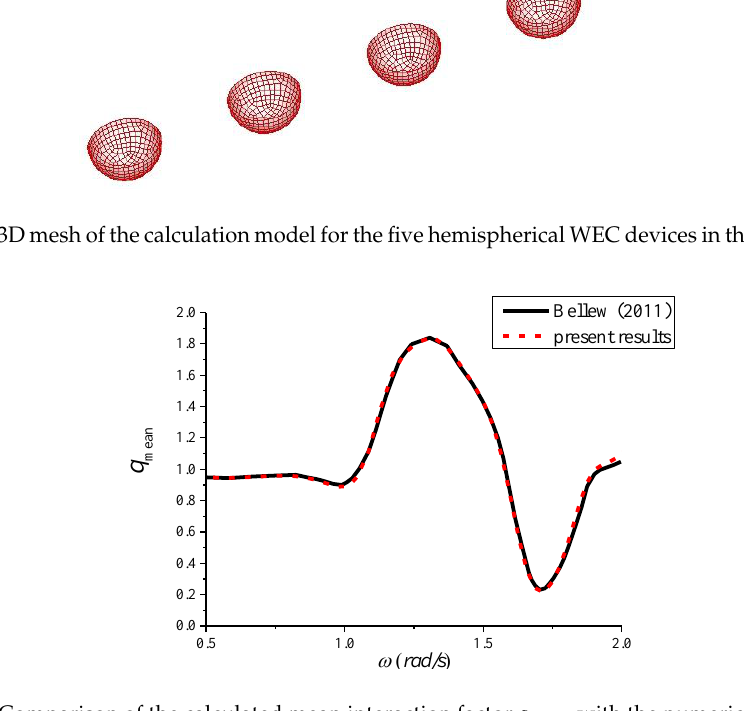
Figure 4. 3D mesh of the calculation model for the parametric study. ( T / h = 0.25, D / h = 12 , B / h = 0.6, s 1 / h = 0.5, s 2 / h = 0.2 ) 3.2.1. Effect of the WEC-Pontoon Spacing s 2 Five WEC-pontoon spacings are considered in this subsection. The parameters of draft T / h , the length D / h , and the breadth B / h of the pontoon, WEC-WEC spacing s 1 / h , and WEC-pontoon spacing